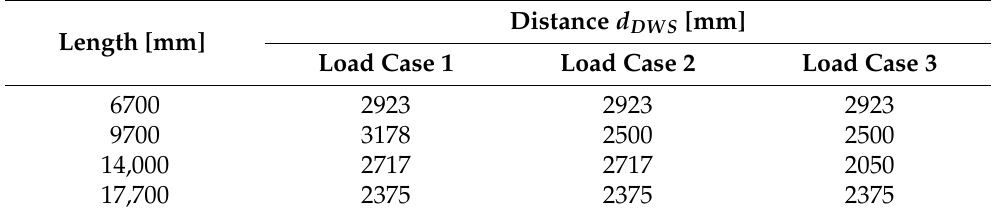
Table 3. DWS for all the torsion test scenarios.